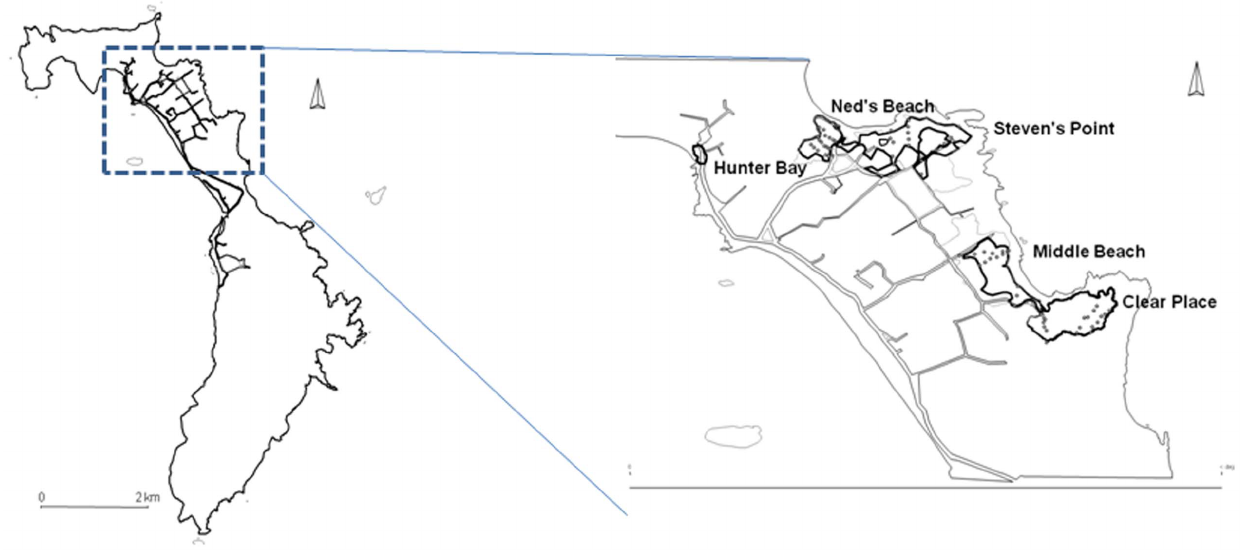
Figure 5. Location of colonies. Map of Lord Howe Island with location of flesh-footed shearwater breeding colonies and roads. Positions of stations used for estimating breeding success marked as circles.